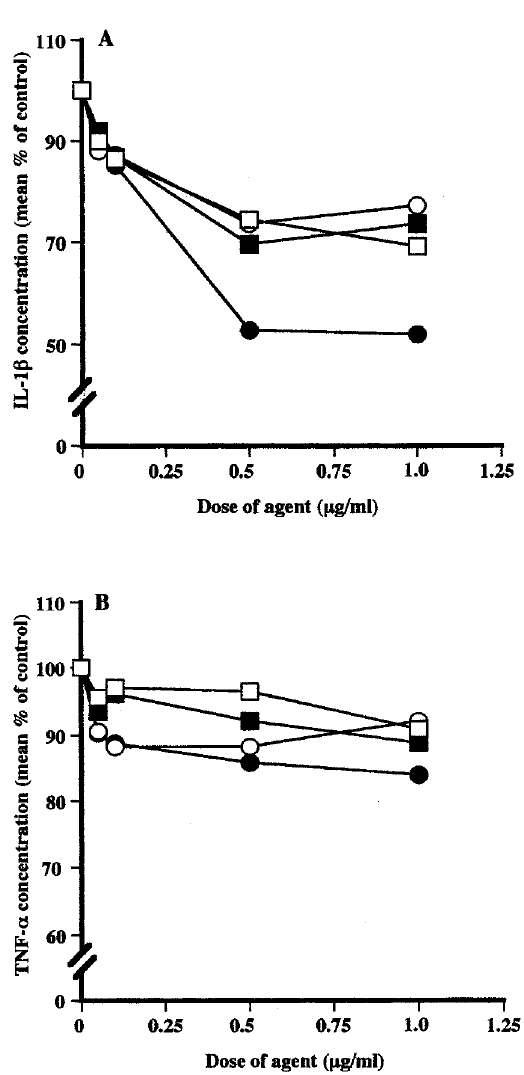
FIG. 2. Influence of metabolized RXM on pro-inflammatory cytokine production from human PBM in response to LPS stimulation in vitro . The cells (2 3 10 6 /ml) were cultured in the presence of various concentration of metabolized RXM. The culture supernatants stimulated with 1.0 m g/ml LPS were harvested 24h later. IL-1 b (A) and TNF- a (B) concentrations were assayed by ELISA. Each data is the mean percent of control (without agent) of six different subjects. h : RU28111, j : RU39001, s : RU44981, d :